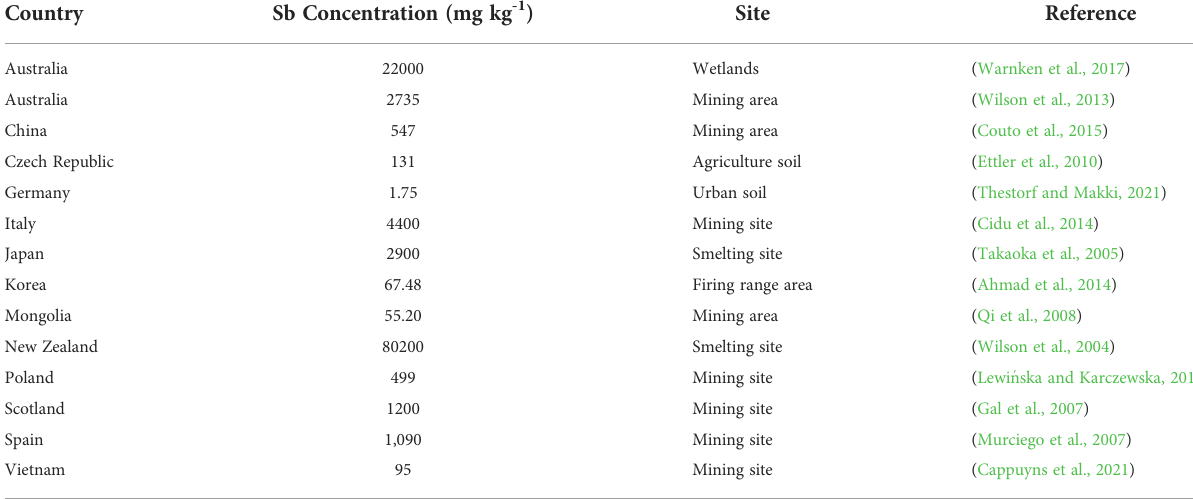
TABLE 1 Concentration of Sb in soils of different countries. Country